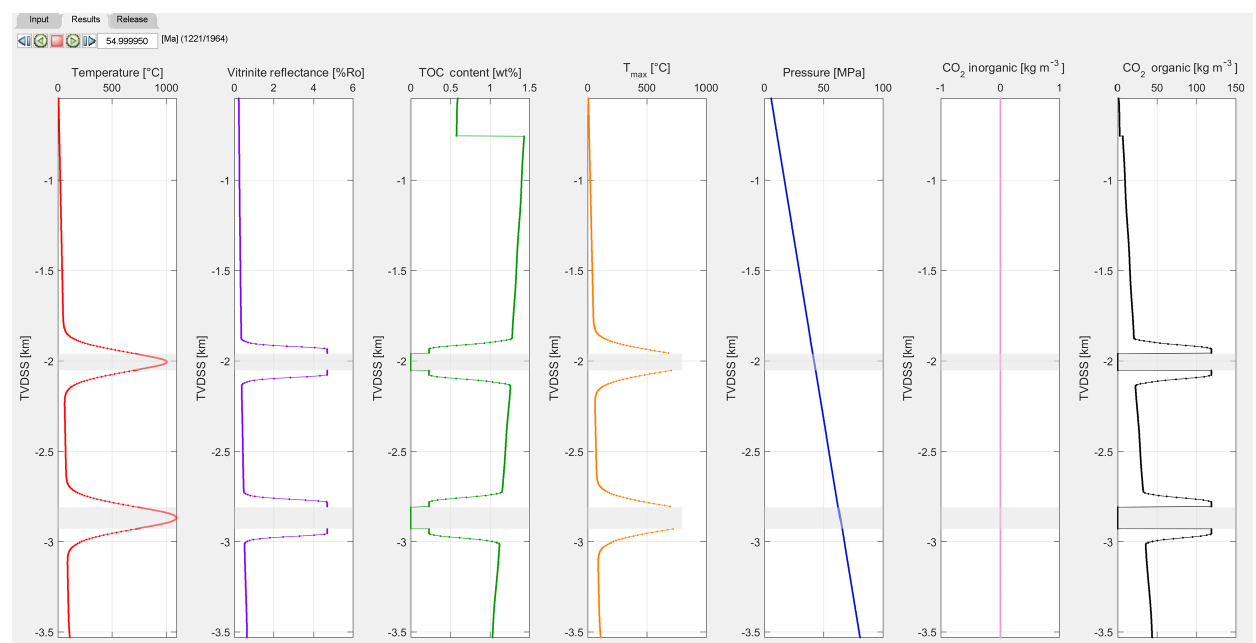
Figure 6. Results tab 50 years after the emplacement of sills at 55Ma for the Utgard High example. Sediments around the sills are heated and CO 2 is liberated as organic matter is thermally